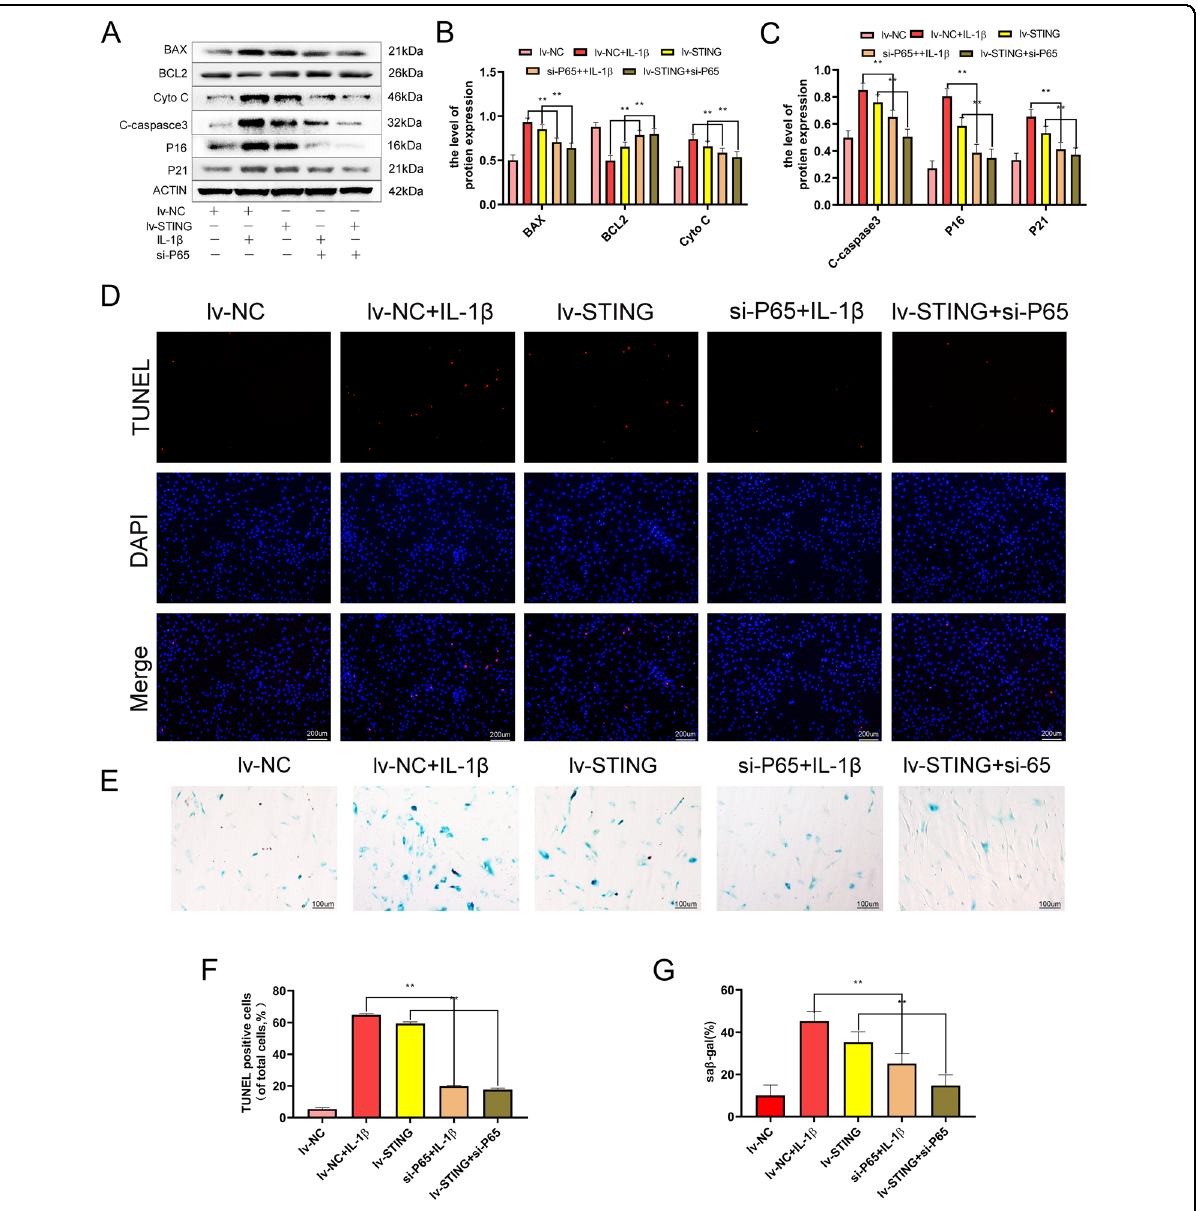
Fig. 5 STING induces chondrocyte senescence and apoptosis via NF- κ B activation. The mouse chondrocytes were pre-exposed to lv-STING or si-p65 followed by exposure to IL-1 β (10 ng/ml) for 24 h. A – C Western blot and its quanti fi cation of the level of BAX, BCL-2, Cyto-c, cleaved-caspase-3, p16INK4a and p21. D – F TUNEL staining assay was conducted on the chondrocytes, as treated above (bar: 100 μ m). E – G SA- β -gal staining assay was carried out on chondrocytes, as shown (bar: 50 μ m). All data were indicated as mean ± SD ( n = 5); ** P <